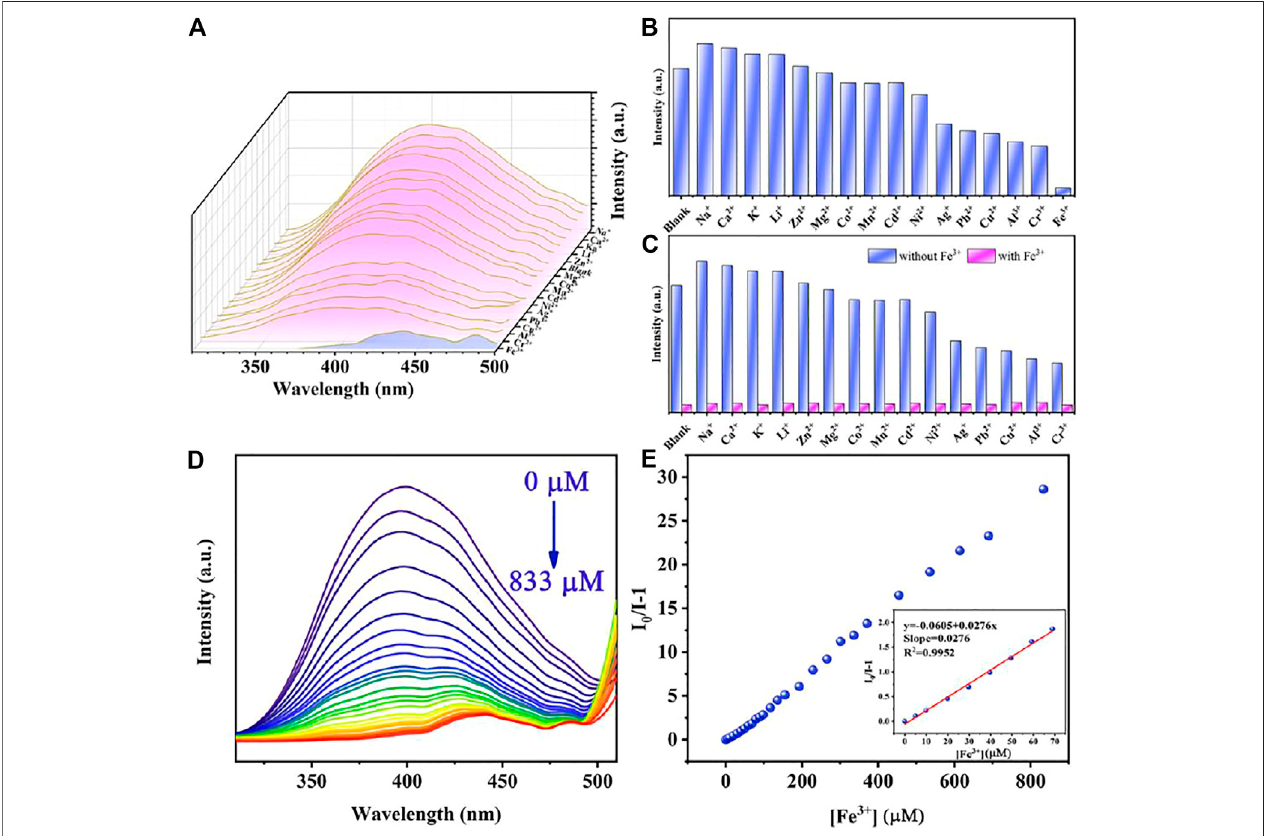
FIGURE3|(A) EmissionspectraofCu 0.1 /Zn-MOFimmersedinaqueoussolutionswithmetalions. (B) SensingeffectsofCu 0.1 /Zn-MOFondifferentmetalions. (C) Selective detection of Fe 3+ on Cu 0.1 /Zn-MOF in the presence of different metal ions in aqueous solutions. (D) Photoluminescence spectra of Cu 0.1 /Zn-MOF in aqueous solutions upon incremental addition of Fe 3+ . (E) Stern – Volmer plot of Cu 0.1 /Zn-MOF upon adding different concentration of Fe 3+